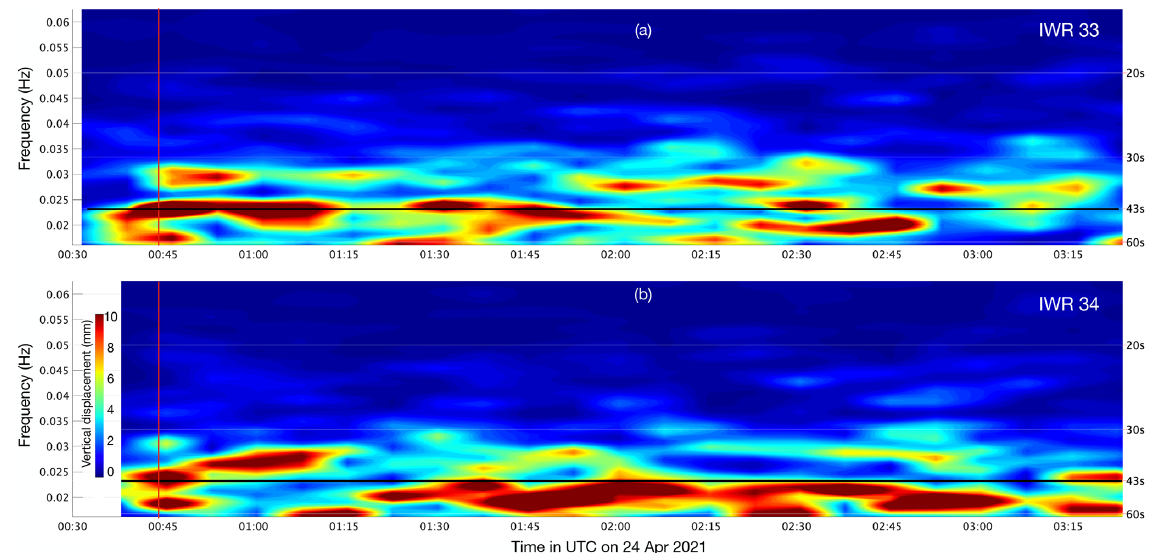
Figure 7. Spectra of the wave amplitude computed from the vertical acceleration from IWR 33 (Fig. 4) and from IWR 34 presented as ∼ 3h Welch plots from 24 April 2021. The displacement of IWR 33 is centered on a period of 43s (black lines) at 00:44UTC (time indicated with vertical red line).